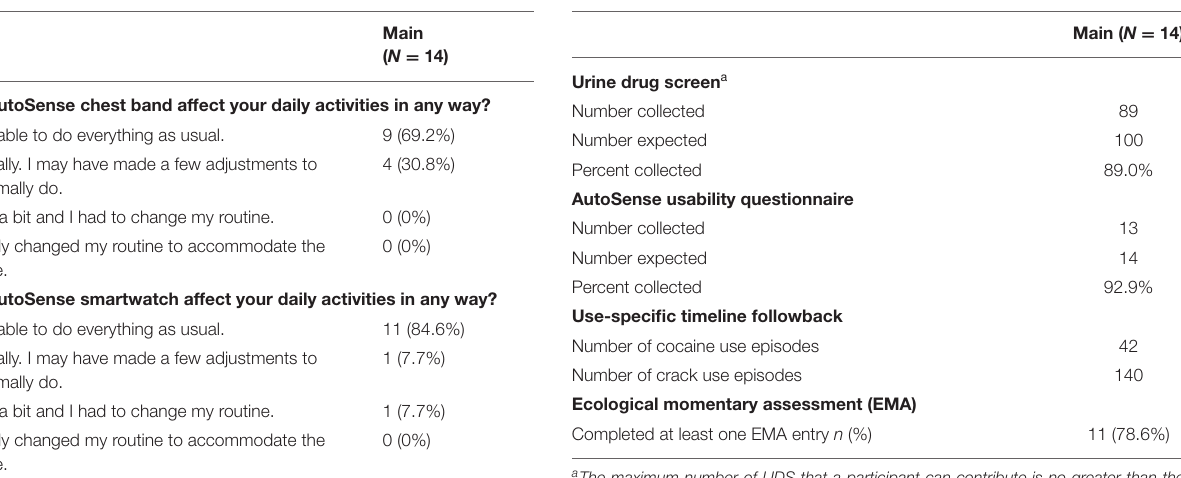
TABLE 3 | Availability of primary outcome data in the main